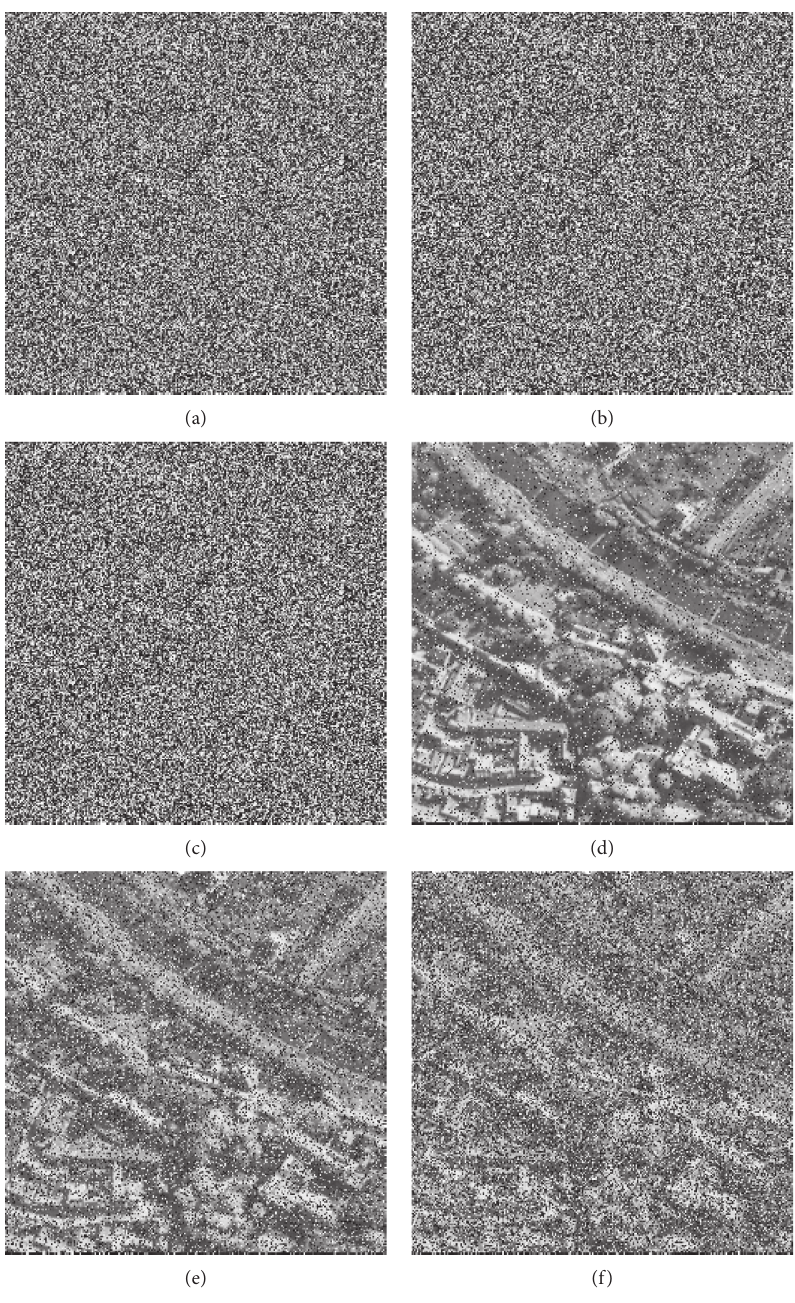
Figure 11: Noise attack analysis: (a, b, c) the noisy encrypted images by SPN with 0 . 01 , 0 . 03 , and 0 . 05 densities; (d, e, f) the deciphered images of (a), (b), and (c). Table 8: Noise attack analysis-I